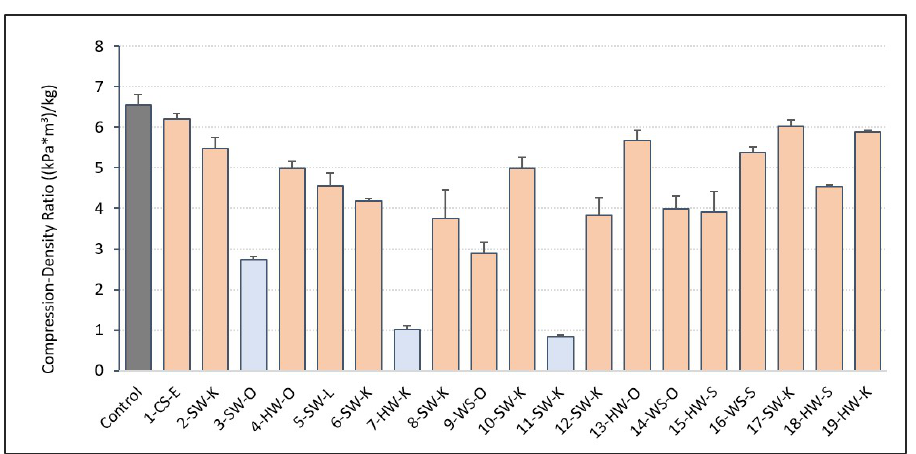
Figure 5. Compression–density ratio (CDR) of formulated foams. Foams in blue failed in compression testing. The compression strength of lignin-based foams was negatively correlated (r = −